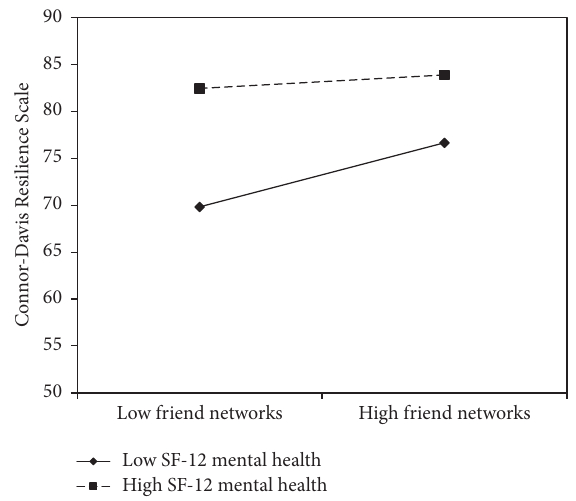
Figure 2: The simple slopes of Lubben Social Network Scale-6 friend networks on Connor-Davis Resilience Scale scores at high and low levels of SF-12 Mental Health Component Summary